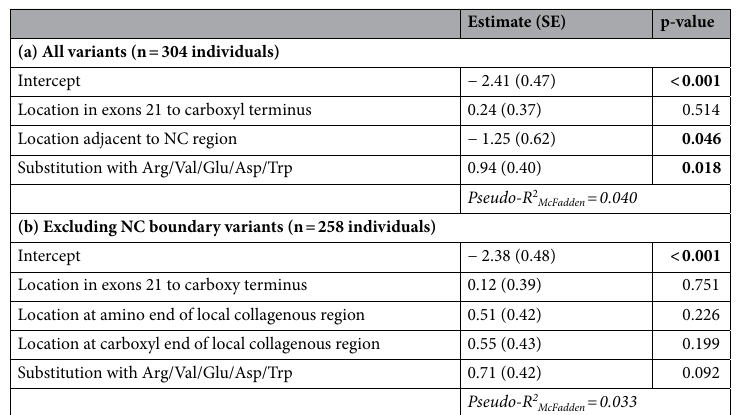
Table 4. Logistic regression model of molecular characteristics of COL4A3 and COL4A4 Gly missense variants associated with haematuria in the 100kGP database. NC, non-collagenous; SE, standard error. Significant values are in bold.